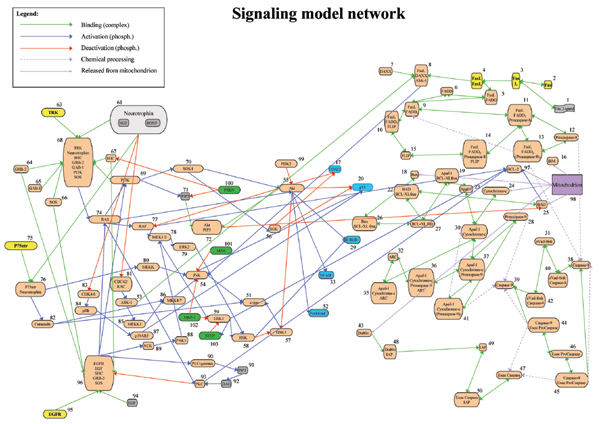
Scheme of a model signaling network. Scheme of the signaling network used to demonstrate the validity of the parameter estimate method. The network consists of a series of proteins (the nodes) linked by different types of unary, binary or multiple molecular interactions (shown as the edges of the network). The role of the mitochondrion (in purple) is taken into account. Binding protein-protein interactions are shown by green edges between the nodes, activation and deactivation interactions are in blue and red, respectively, chemical transformations are shown by purple dotted lines, while the release of proteins from the mitochondria in shown in solid purple lines. The signaling process can be activated by the binding of ligands (in grey) to receptors. Every compound is identified by a name and a numerical code.